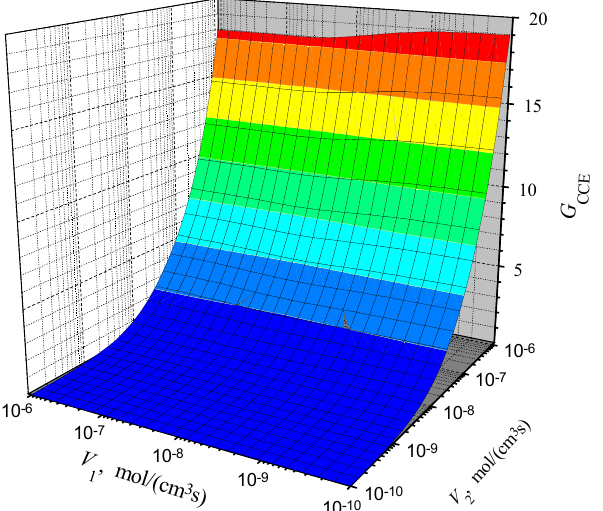
versus the maximal enzymatic rates V CCE